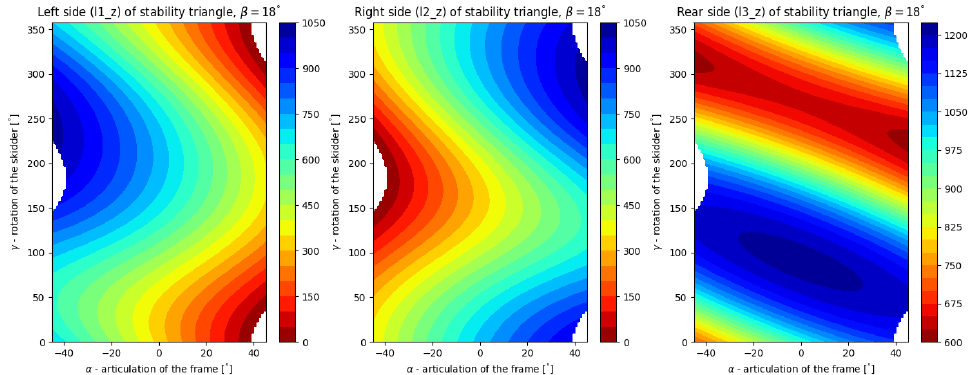
Figure 11. Firefighting device stability for half-filled water tank (1000 L) behind rear axle, and additional weight (500 kg) in the front (C5 config.).